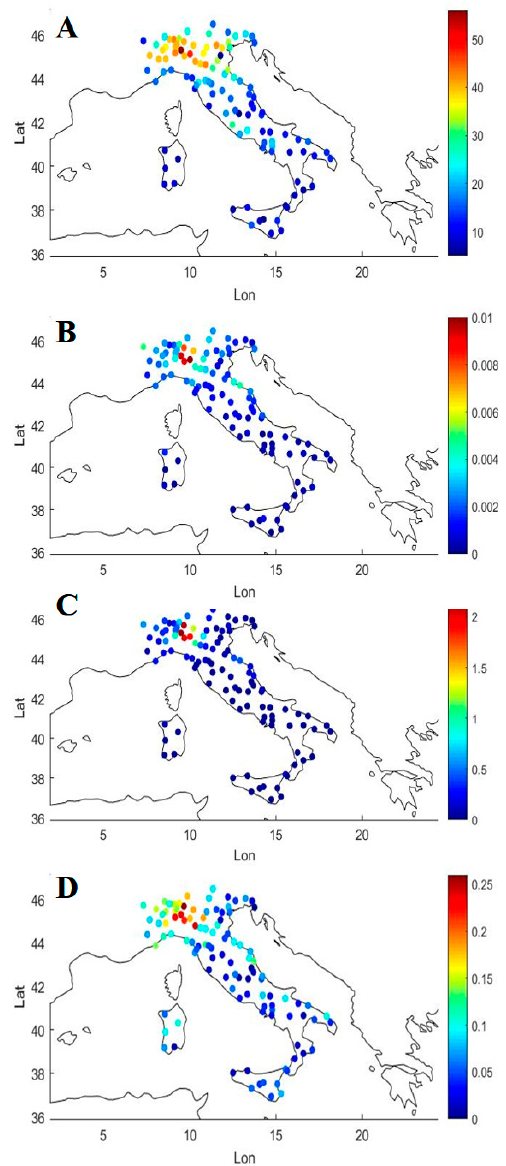
Figure 3. PM 2.5 concentrations averaged over the period 15–26 February 2020 for the 110 Italian Provinces ( A ); incidence of COVID-19 ( B ), mortality rate ( C ) and case fatality risk ( D ) over the period